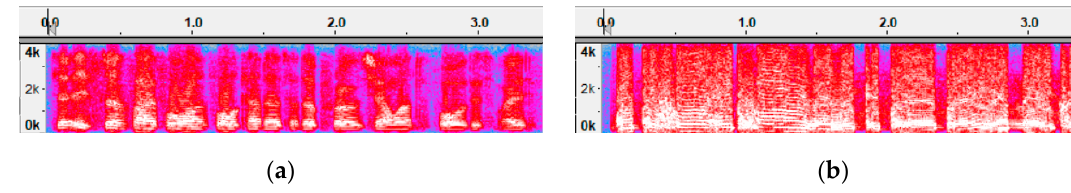
Figure 4. ( a ) Spectrogram of an ATC speech segment; ( b ) Spectrogram of another ATC speech segment collected from the same transmission channel with ( a ).